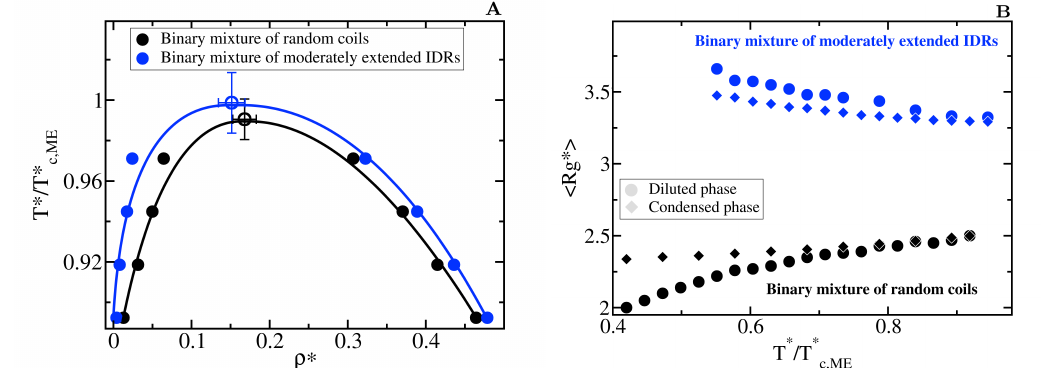
Figure 7. Impact of the conformational plasticity in heterotypically driven LLPS ( A ) Liquid-liquid coexistence lines of two 50:50 binary mixtures of 20-bead IDRs with different conformational ensembles: filled black circles represent the coexistence densities for a mixture of fully flexible random coils while blue circles for a mixture of moderately extended IDRs. Empty circles indicate the estimated critical point of each mixture. Note that temperature is renormalized by the critical temperature of the moderately extended IDR binary mixture, T ˚ = 3.8. ( B ) Average radius of gyration, ă R ˚ g ą of c , ME the IDRs as a function of the renormalized temperature, T ˚ { T ˚ . Circles indicate ă R ˚ g ą in the c , ME diluted liquid phase and diamonds inside the condensed one. The same colour code of the aside panel applies